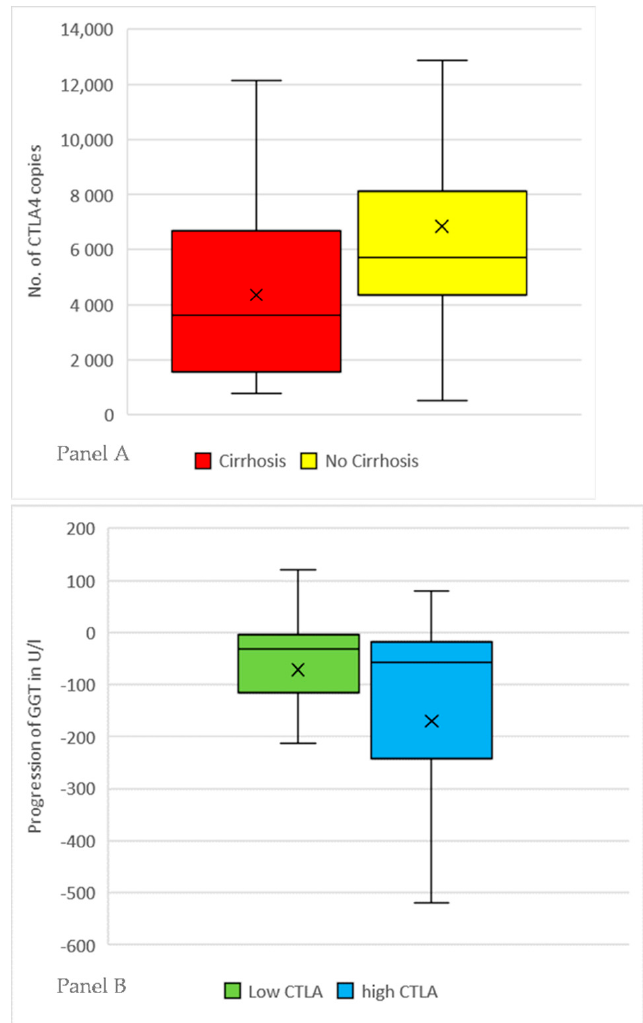
Figure 1. Panel A : Patients with primary biliary cholangitis (PBC) or primary sclerosing cholangitis (PSC) were subgrouped by presence of cirrhosis. The number of CTLA-4 copies was measured using mRNA Real-Time PCR and normalized by β -Actin as internal control. The X marks the mean value, the line inside the boxplot the median. Patients with cirrhosis have a mean number of 4359 copies, patients without cirrhosis have a mean number of 6836 copies ( p = 0.04). Panel B : Patients with PBC were sorted by the determined number of CTLA-4 copies. Three equally large groups with either low, medium or high expression were formed. Patients with high and low expression were compared in the course of their disease by subtracting the lab values at initial diagnosis with the most current values for each patient. Patients with high CTLA-4 tend to have a recovery of elevated GGT-values more often [low: − 69.8 U / l vs. high: − 176.1 U / l p = 0.04]. The X marks the mean value, the line inside the boxplot the median. Patients with PSC showed the same trend without reaching statistical significance (low: − 45.3 U / l vs. high: − 105.4 U / l p = 0.08).